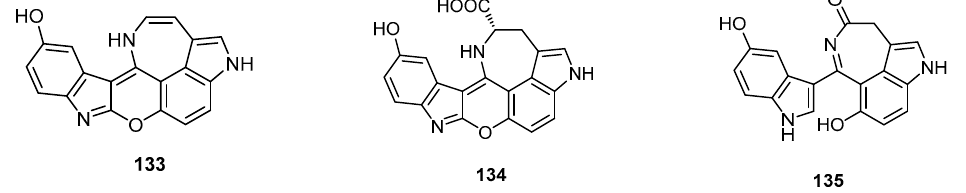
Figure 36. Chemical structures of hyrtimomine A ( 133 ), hyrtimomine B ( 134 ) and hyrtimomine C ( 135 ).